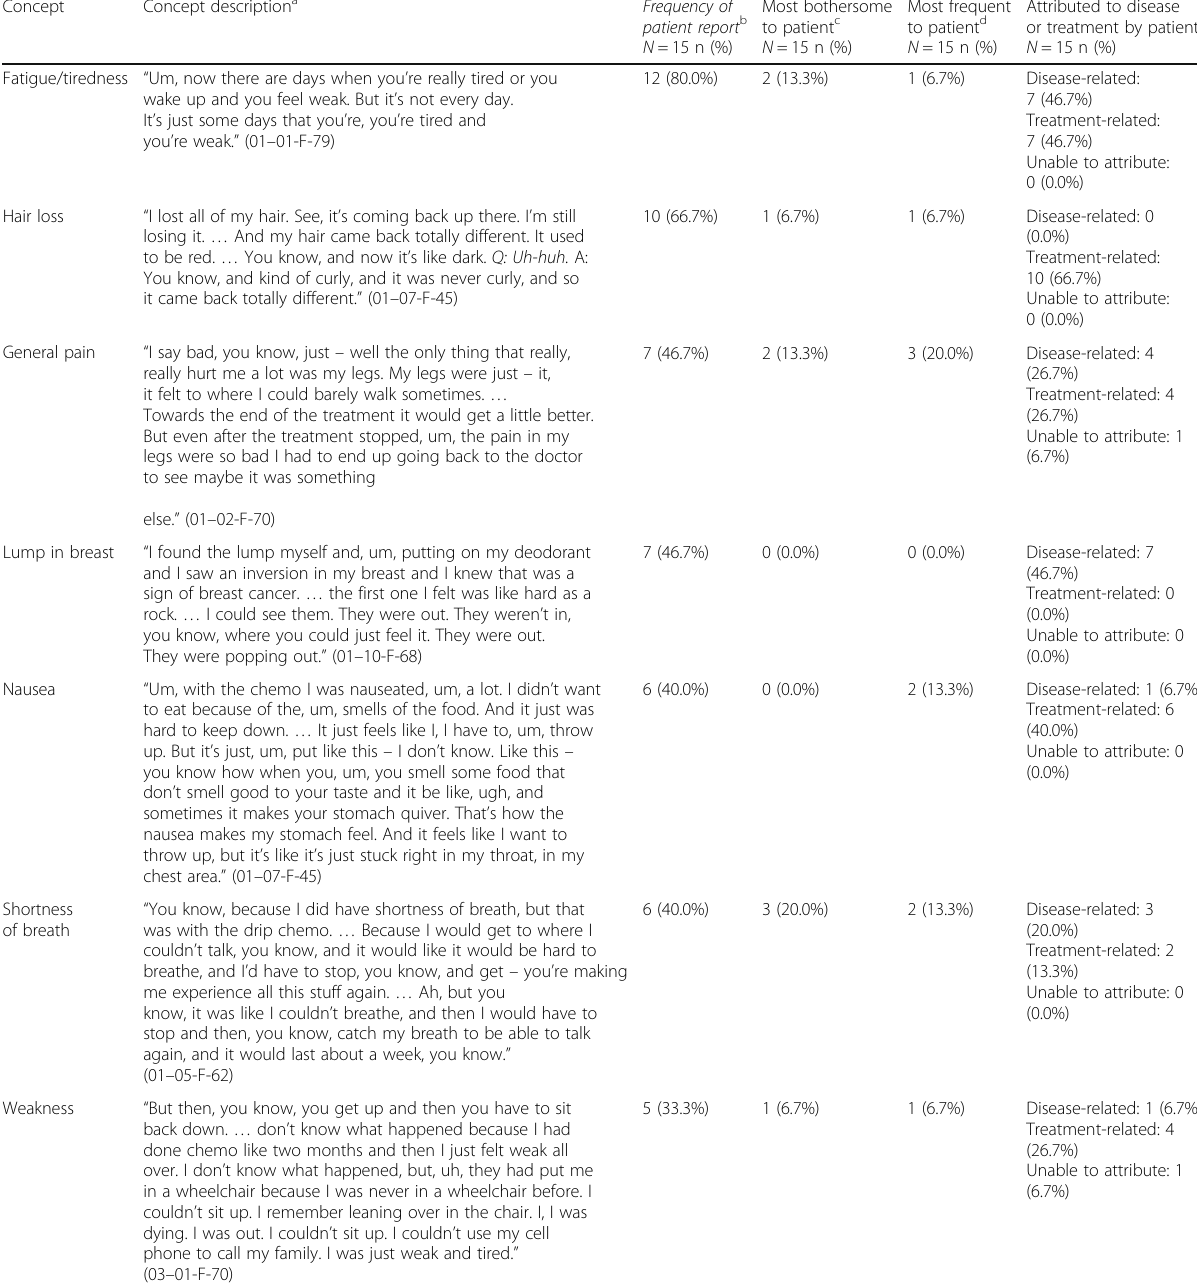
Table 3 Patient-reported HR+/HER2- advanced breast cancer disease-and treatment-related concepts reported by ≥ 33.3% of patients (frequencies and